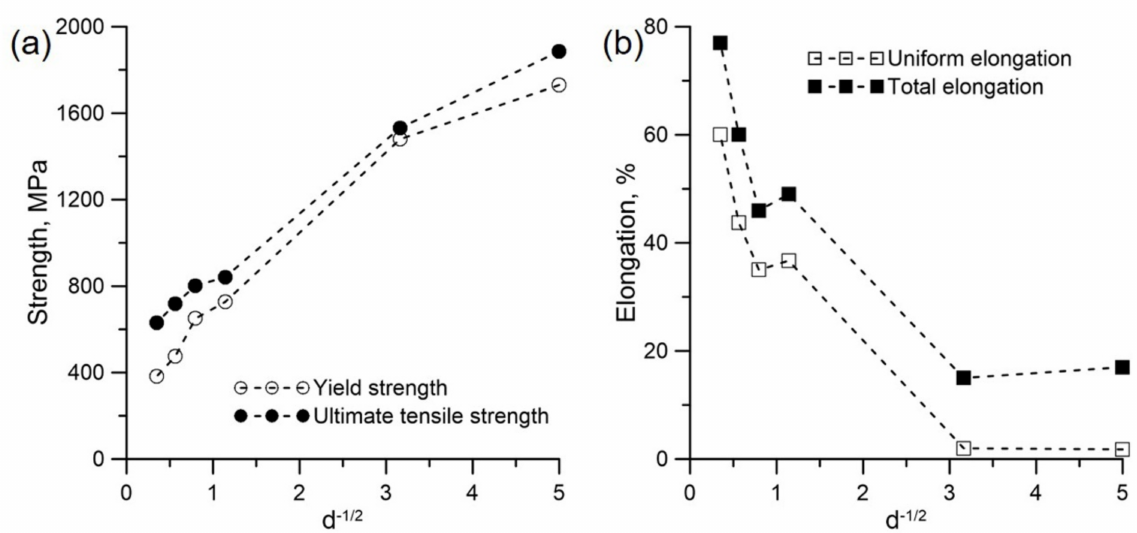
Figure 6. Effect of grain size on ( a ) strength and ( b )